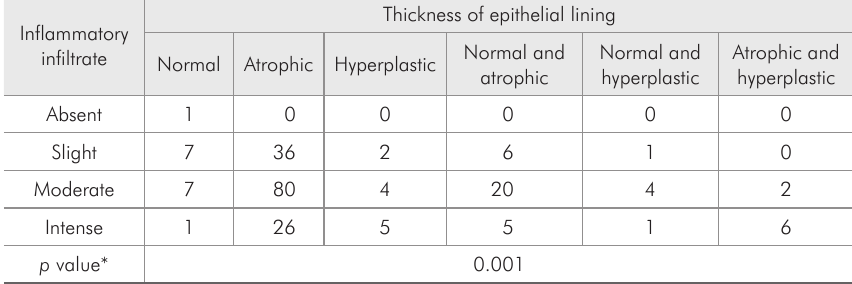
Table 1 - Intensity of inflammatory infiltrate according to thickness of epithelial lining in periapical cysts.